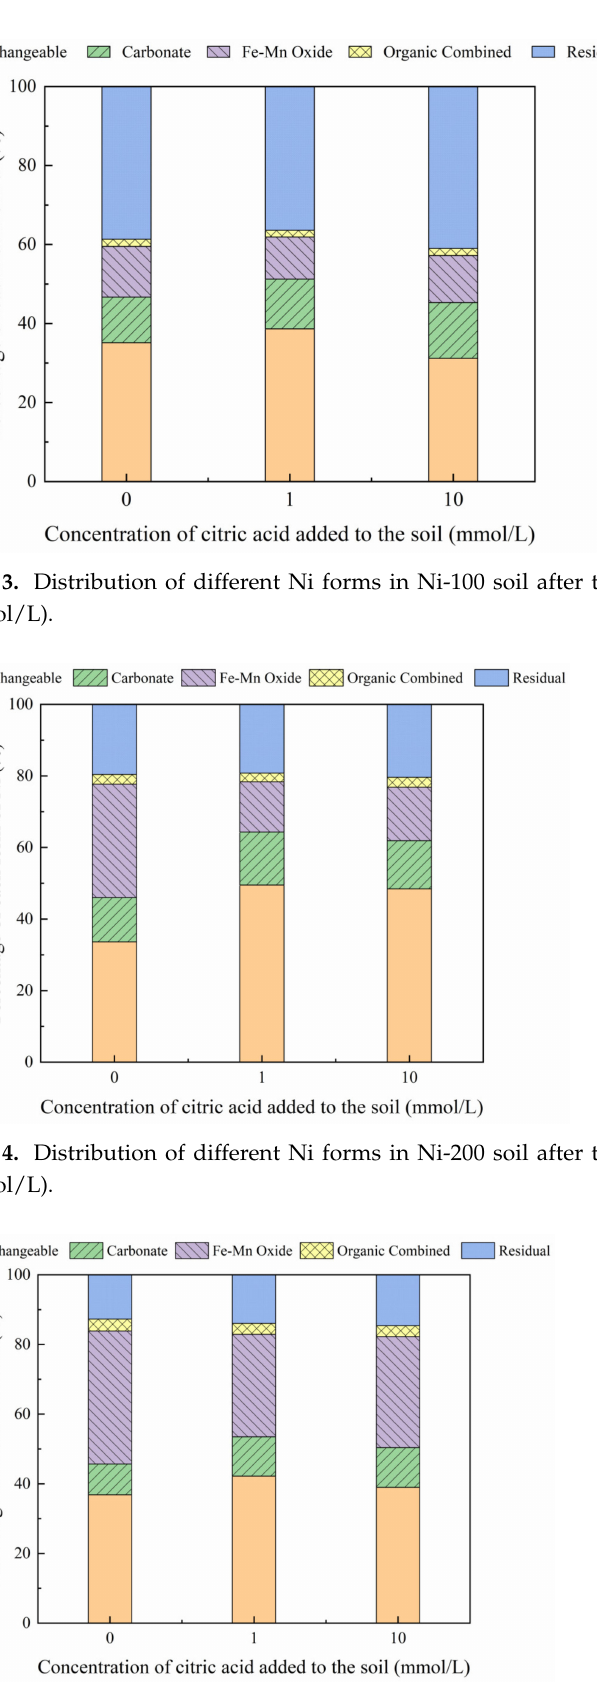
Figure 5. Distribution of different Ni forms in Ni-300 soil after the addition of citric acid (0, 1, 10